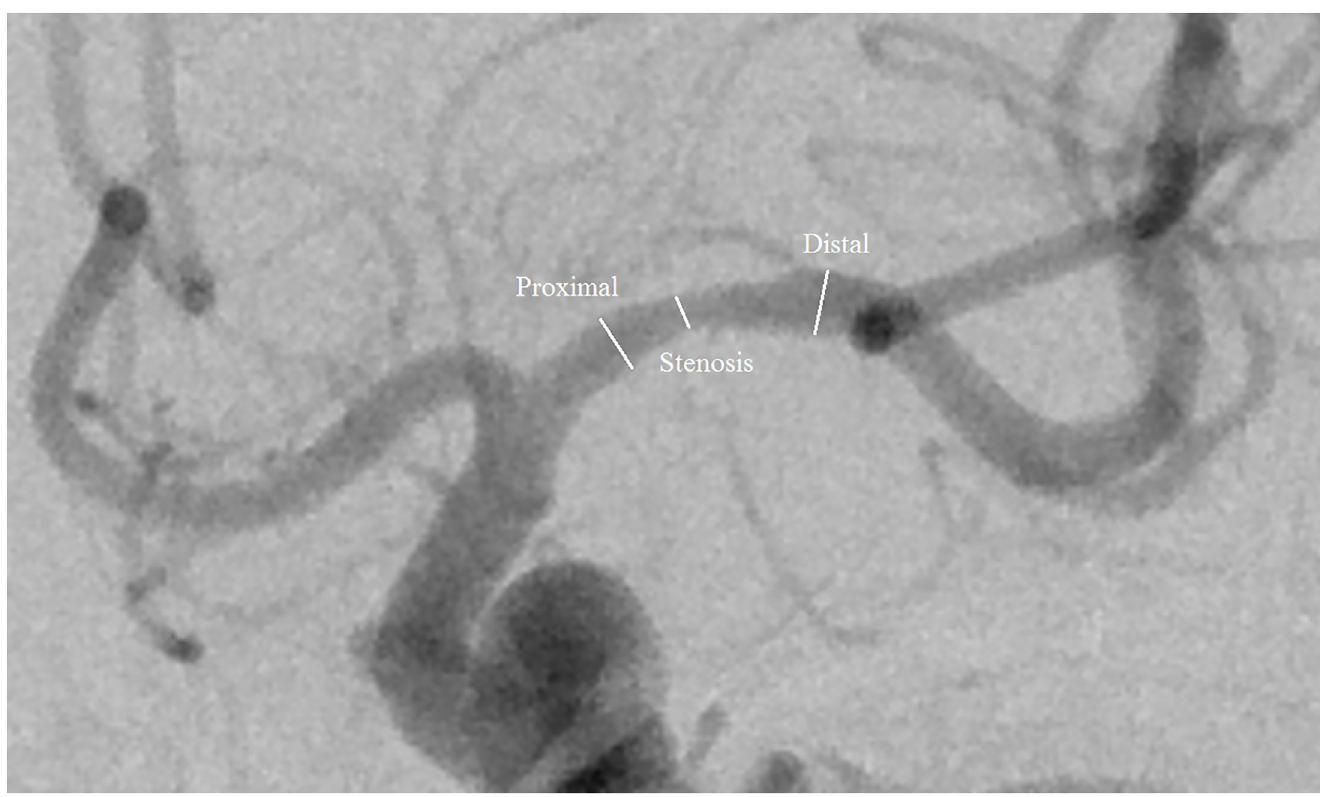
Fig 1. Digital subtraction angiography image showing the points where measurements were taken. The NASCET method uses the distal segment as a comparator to the stenotic region. The WASID method divides the stenotic segment measurement by the proximal normal